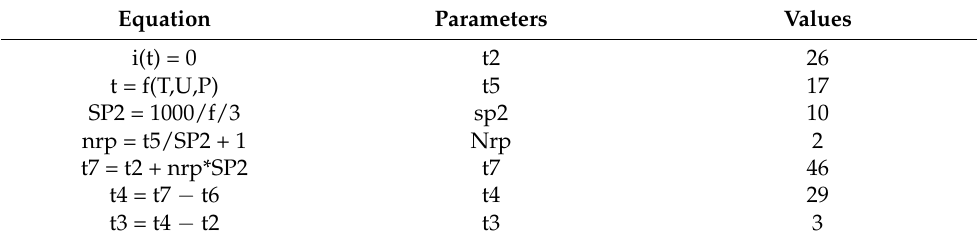
Table 6. The equation used in simulation of the disconnection process of the circuit-breaker.